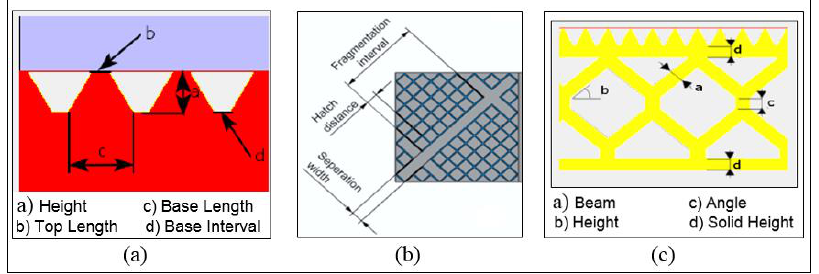
Figure1. Designparameters: ( a )toothparameters,( b )fragmentationparameters,( c Figure 1. Design parameters: ( a ) tooth parameters, ( b ) fragmentation parameters, ( c ) perforation parameters.